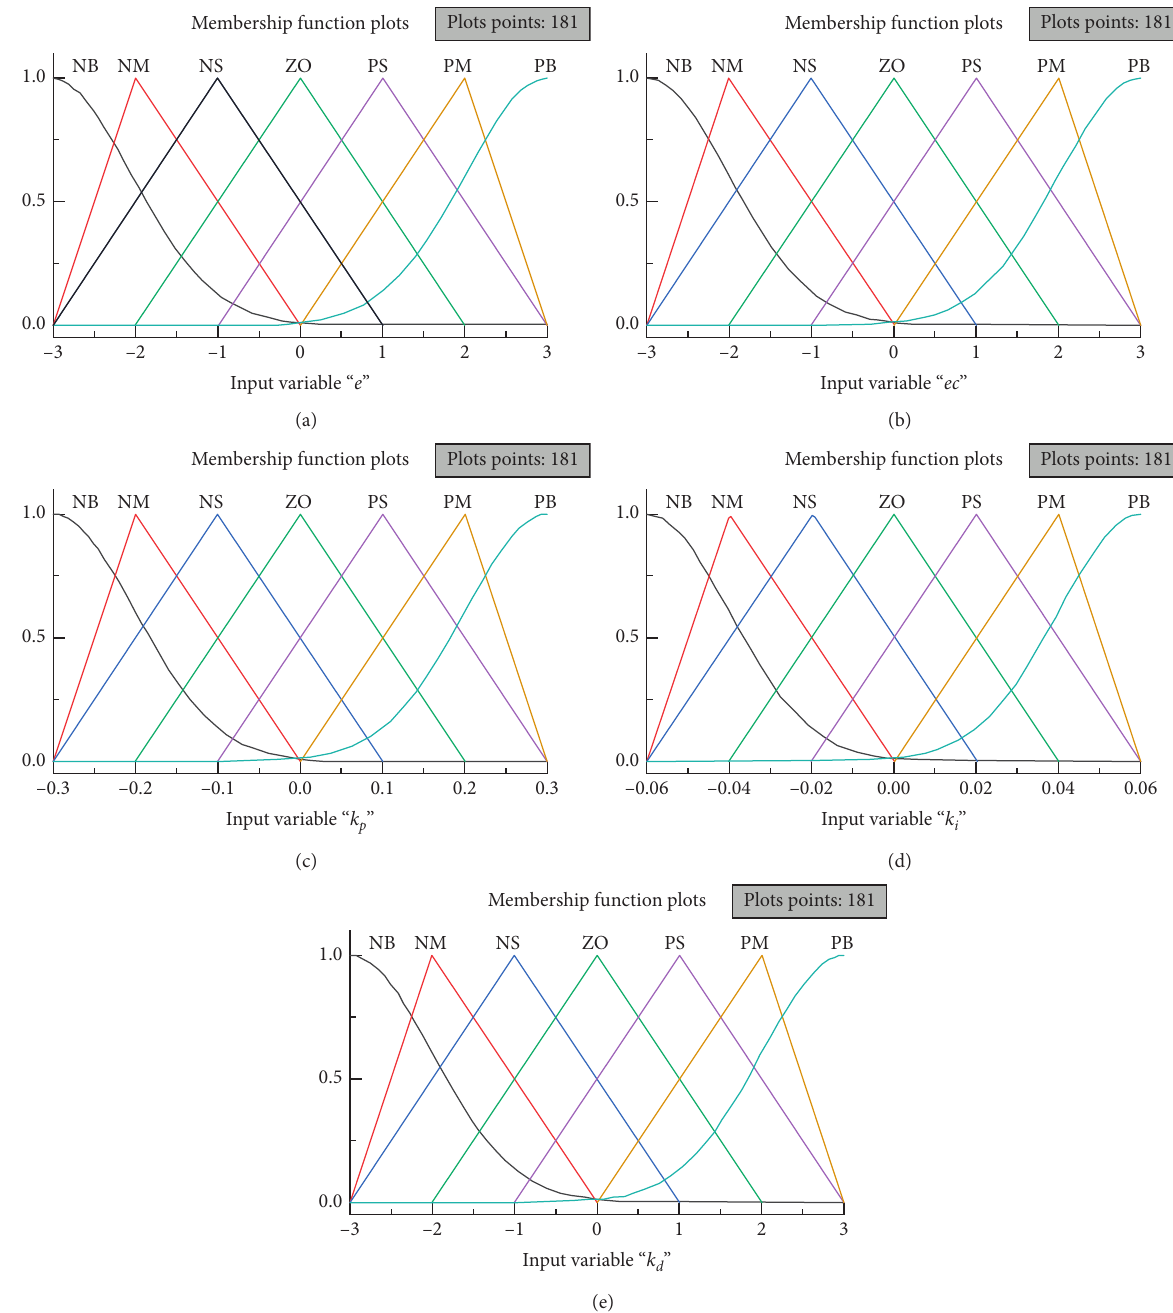
Figure 4: Fuzzy membership